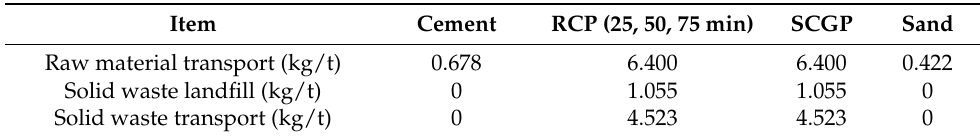
Table 4. CO 2 emission components for raw materials. Reproduced with permission from [5]. Cop- yright John Wiley and Sons, 2020. Item